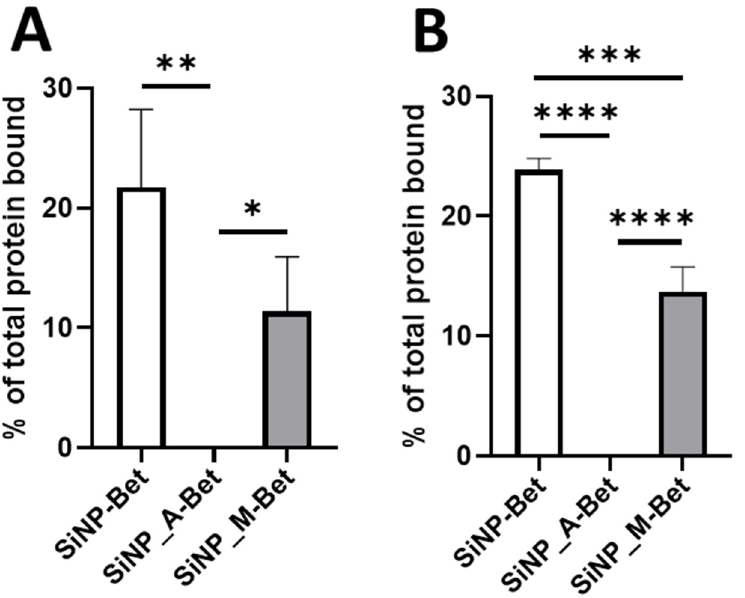
Figure 3. The binding efficiencies of differently functionalized SiNP samples were determined ( A ) directly from the pellet by SDS-PAGE and ( B ) indirectly from the supernatant by BCA assay. The data are presented as mean ± SD ( n = 4) * p ≤ 0.05; ** p ≤ 0.01; *** p ≤ 0.001; **** p ≤ 0.0001.